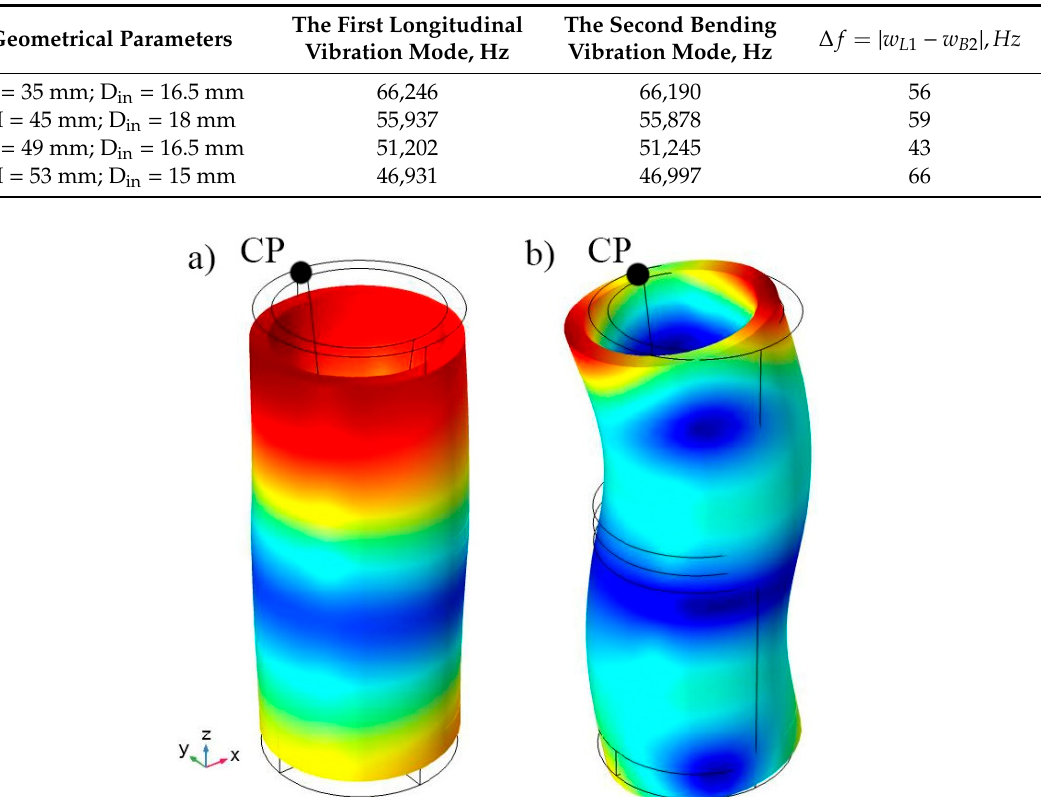
Table 3. The values of design variables and optimization criteria.